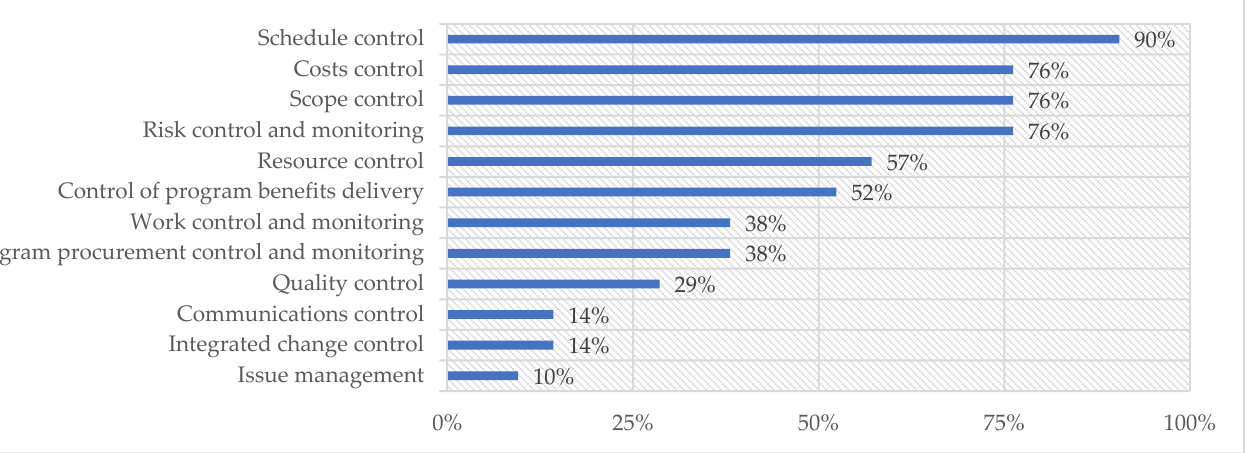
Figure 1. Identified program areas subject to the process of monitoring and control. Source: own elab.